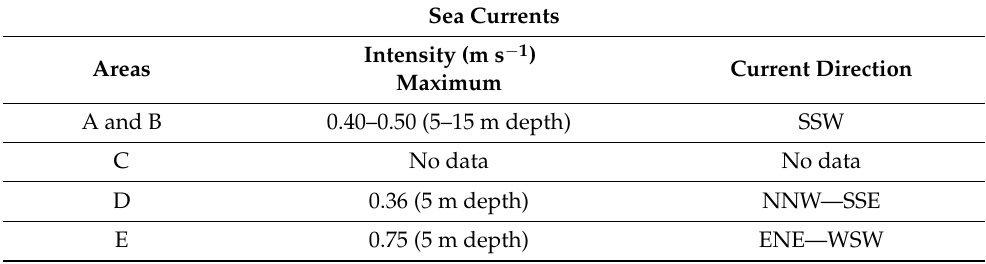
Table 7. Current predominant direction and maximum intensity (m s − 1 ) in the studied